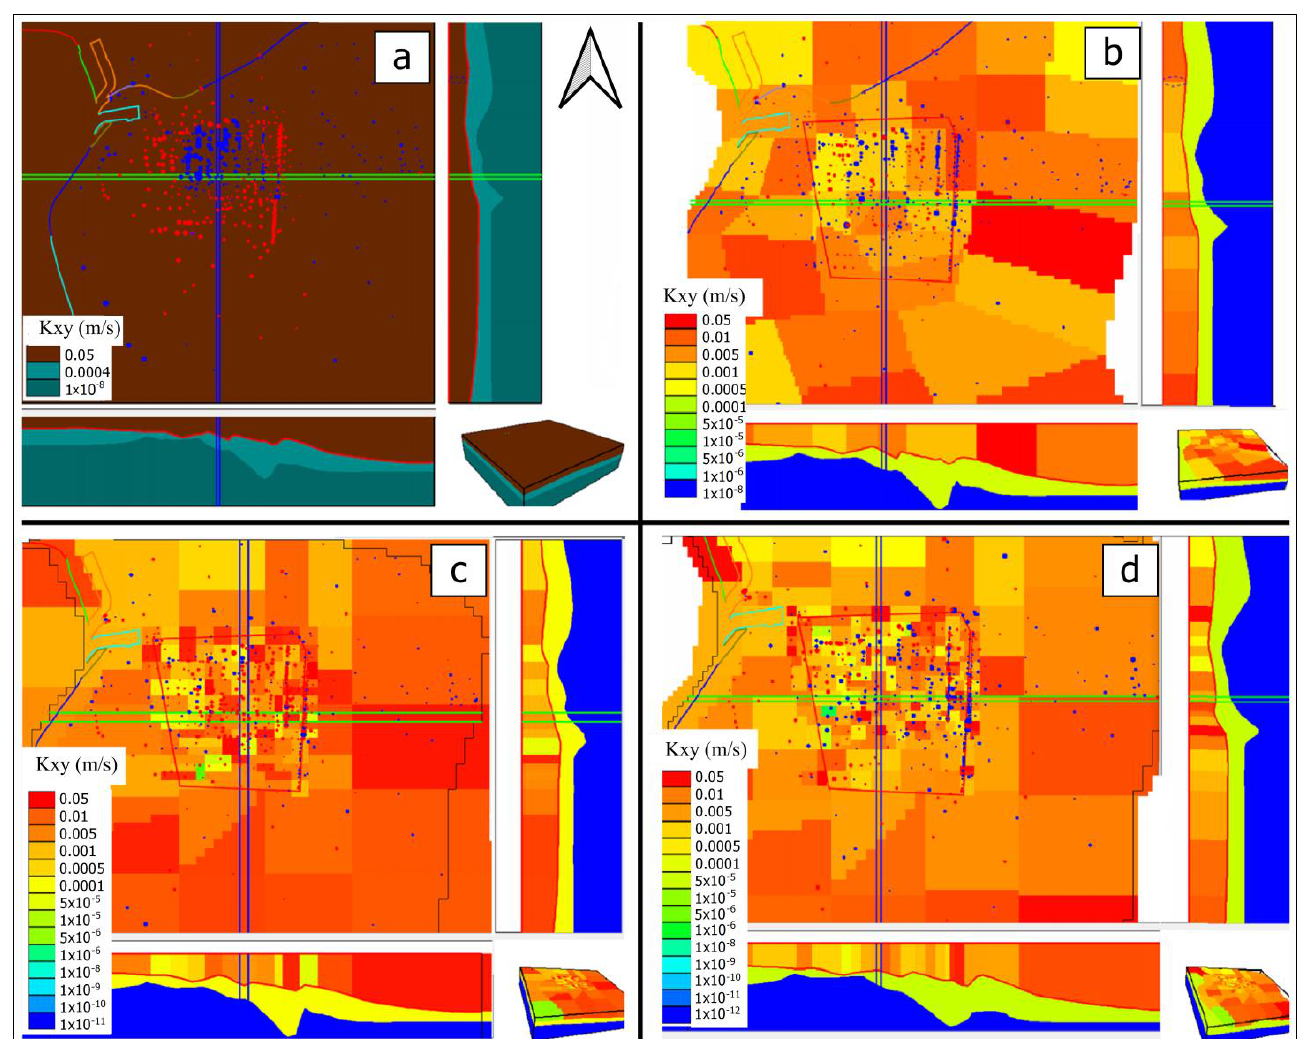
Figure 6. Horizontal hydraulic conductivity (Kxy) zonation within individual model variants (( a ) — V1, ( b ) — V2, ( c ) — V3, ( d ) — V4) with the optimized Kxy values after calibration (planar view and (( a )—V1, ( b )—V2, ( c )—V3, ( d )—V4) with the optimized Kxy values after calibration (planar view vertical cross sections along the blue and green double lines). and vertical cross sections along the blue and green double